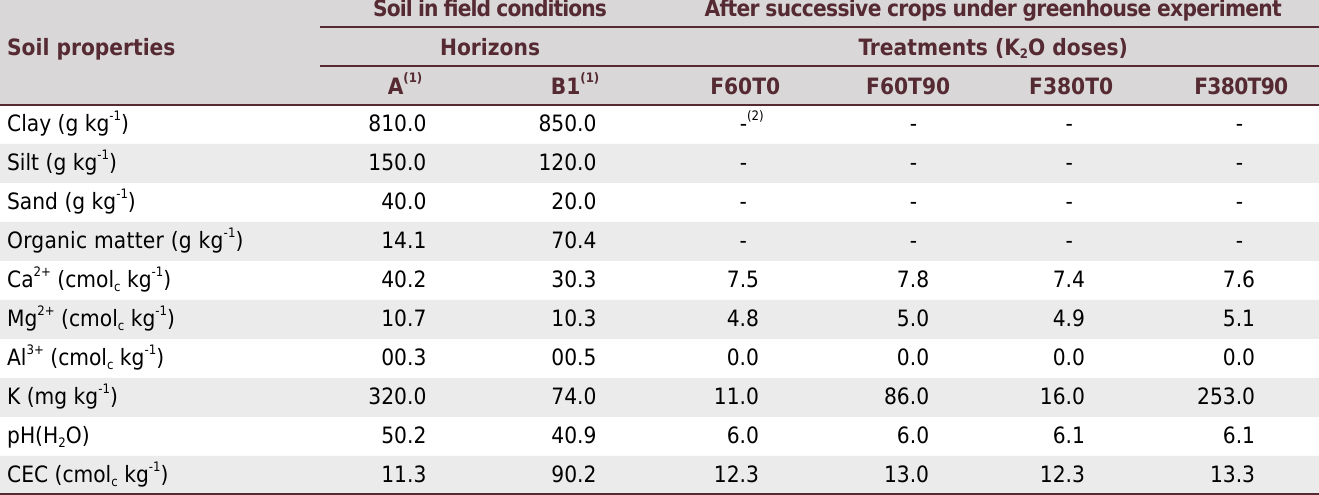
Table 1. Main soil properties of the Ferralsol from Paraná, Brazil, before cropping and after eight successive crops in a greenhouse experiment Soil in field conditions After successive crops under greenhouse Soil properties